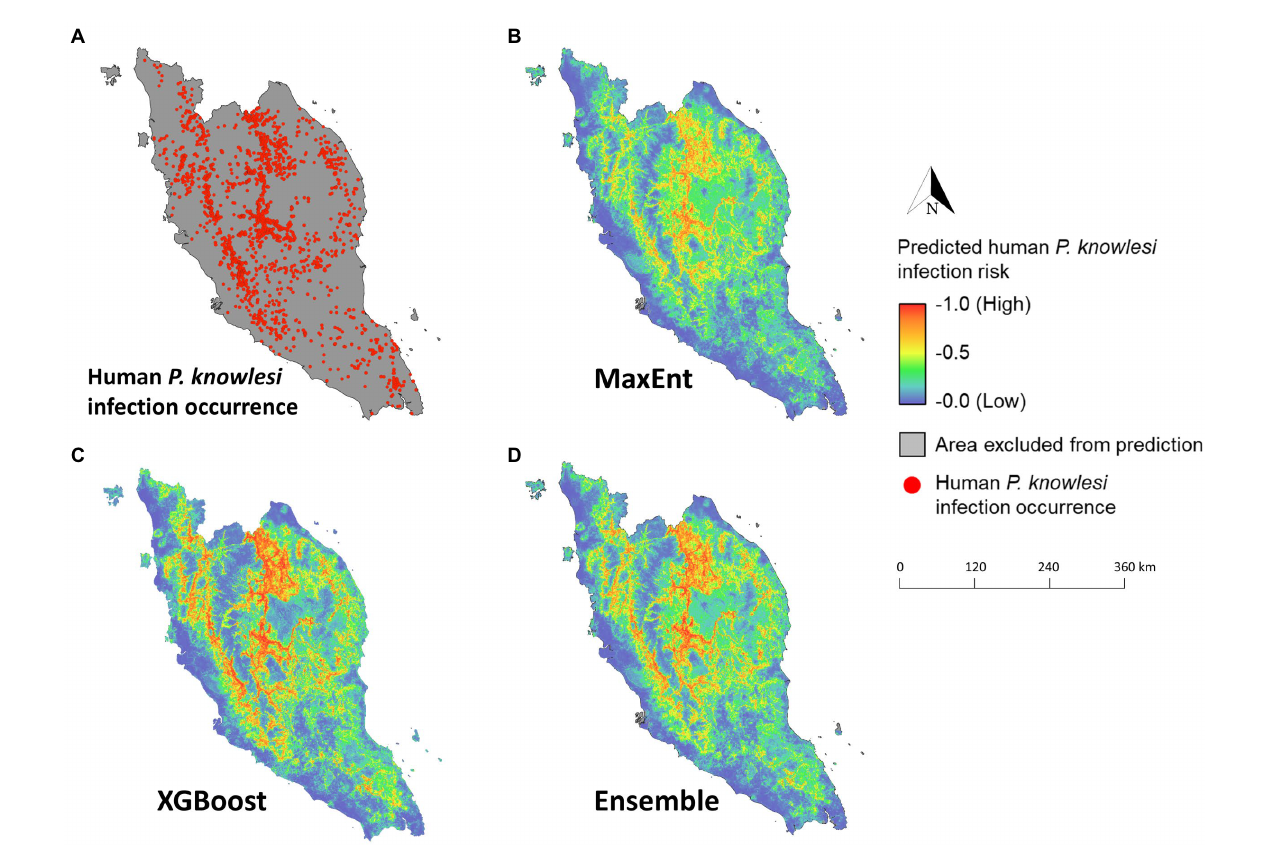
FIGURE 8 Maps of predicted human knowlesi malaria risk in Peninsular Malaysia. (A) Map of geolocated human knowlesi malaria occurrence throughout Peninsular Malaysia from years 2011–2019. Risk maps generated by MaxEnt (B) , XGBoost (C) , and ensemble models (D) . Warmer color indicates higher predicted risk of knowlesi malaria.